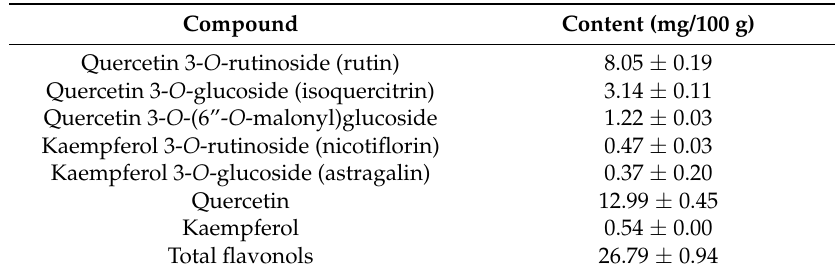
Table 2. Contents of total flavonols isolated from HM.